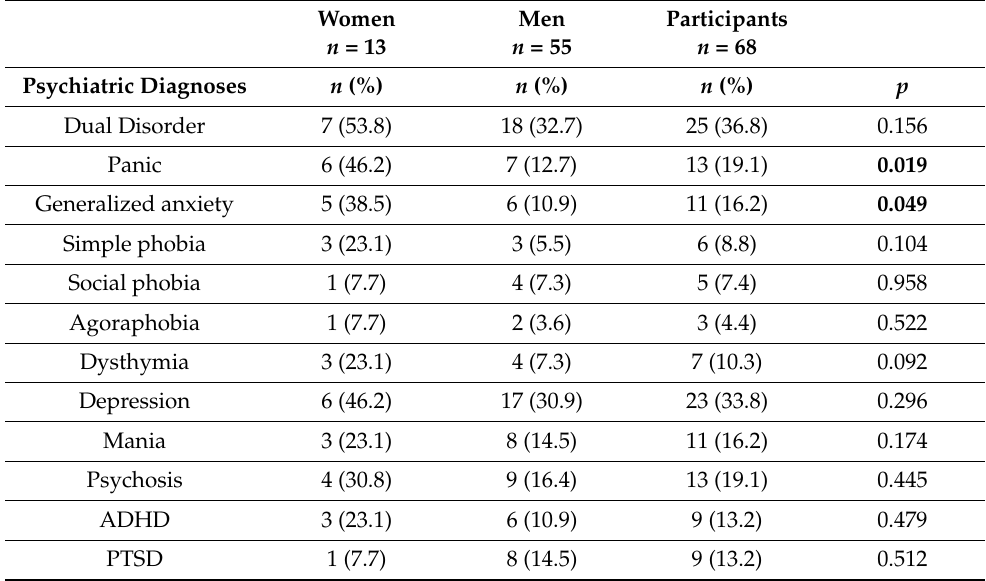
Table 3. Prevalence of DD amongst patients that completed the interview, stratified by gender.